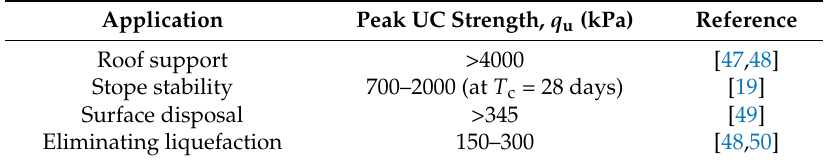
Table 6. Common strength criteria for cemented paste backfills adopted in mining applications.